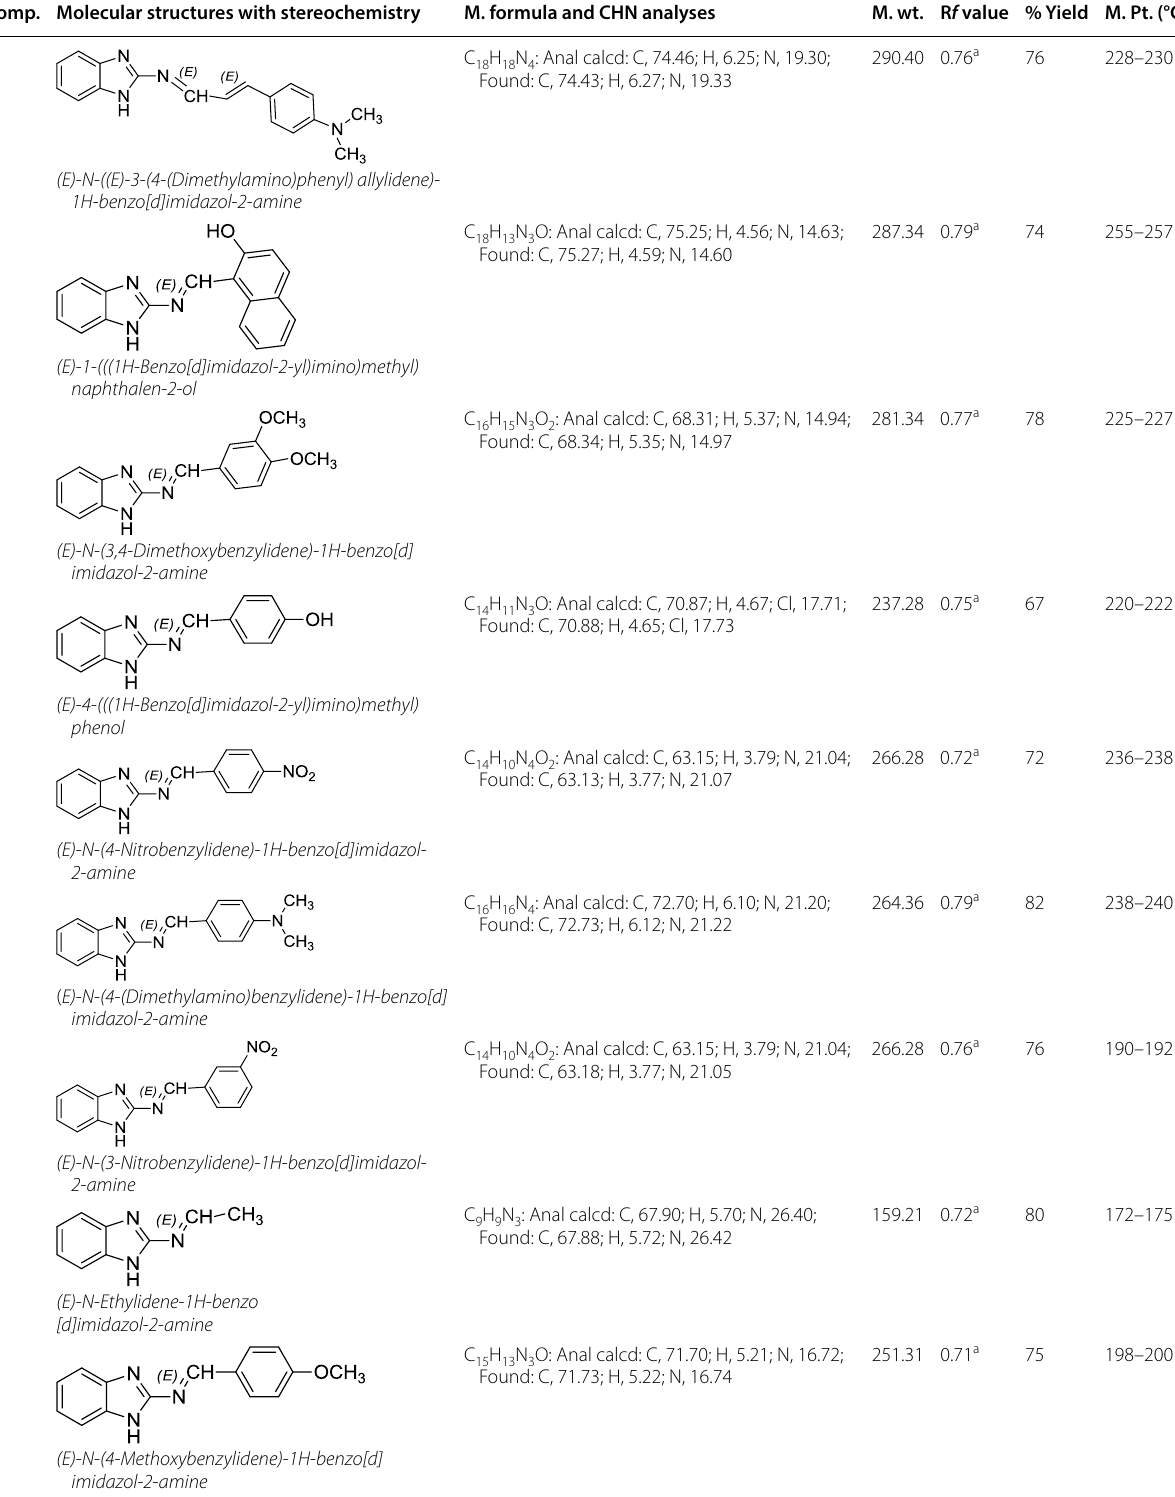
Table 1 Physicochemical characteristic of the synthesized compounds Comp. Molecular structures with stereochemistry M. formula and CHN